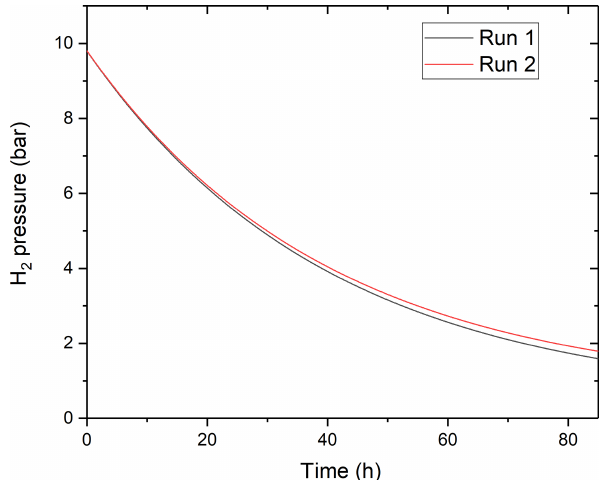
Figure 8. The time-dependent variation of H 2 pressure in the same MHC pressure vessel assembly in two runs at T = 1100 ◦ C con- ducted with a 14-month time gap in between. It is apparent that the hydrogen permeability of the MHC alloy did not change signifi- cantly due to aging of the